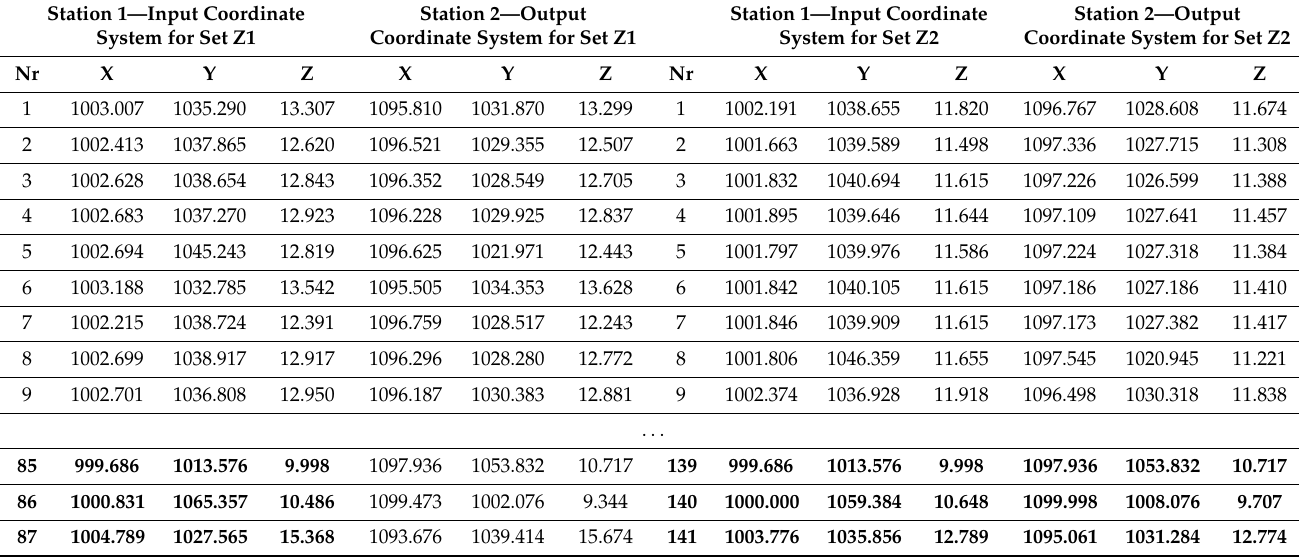
Figure 7. A virtual point cloud in field research for two measurement stations—Z1 dataset in blue color: ( a ) input coordinate system, ( b ) output coordinate system, Z2 in green color ( c ) input coordinate system, ( d ) output coordinate system. Table 3. A virtual point cloud in field research, datasets Z1 and Z2.